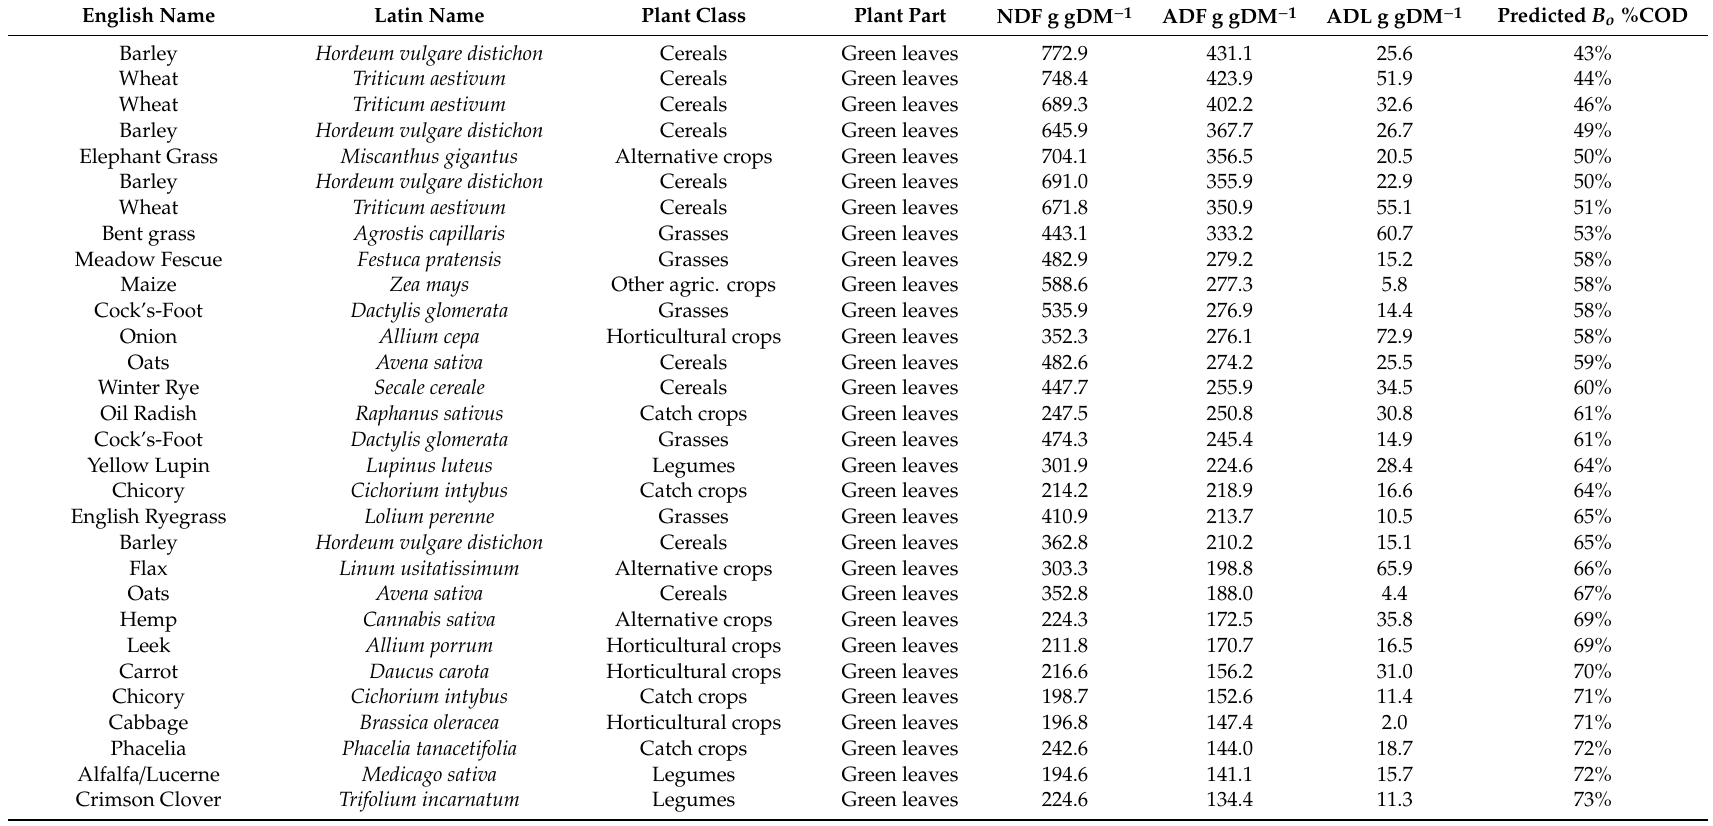
Table A1. Classification, van Soest analysis, and predicted biodegradability ( B o ) of 114 Northern European Plant samples (data from Reference [60]. ( B o was predicted by assuming an average VS value of 92%TS, as assessed in this